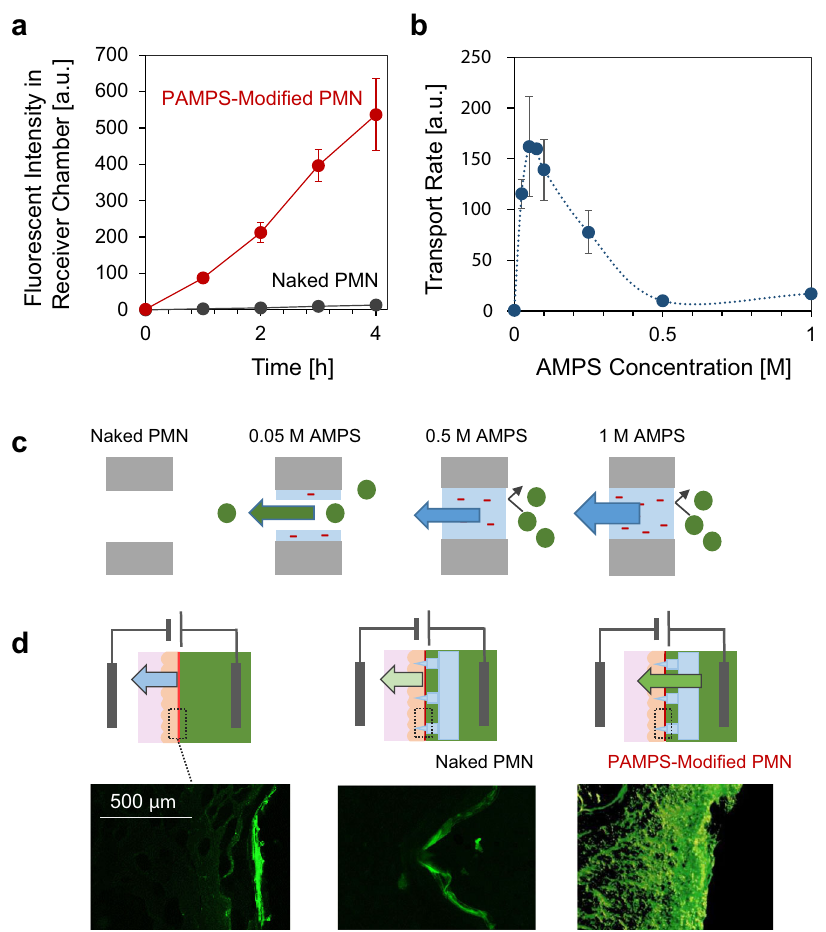
Fig. 4 Transport of large molecules. a The time-course of fl uorescent intensity of FITC-dextran transported to the receiver chamber through the naked PMN (black) and the PAMPS-modi fi ed PMN (red) at 3 mA/cm 2 ( N = 3 independent experiments; mean ± SD). b The transport rate of FITC-dextran at 3 mA/cm 2 as a function of AMPS concentration for modi fi cation of PAMPS ( N = 3 independent experiments; mean ± SD). c Schematic illustration of the sieving effect of the pore- fi lling PAMPS for larger molecules. d Cross-sectional fl uorescence images of pig skins after the transdermal application of 0.5 mA/cm 2 for 30 min without a PMN (left), with a naked PMN (center) and with a PAMPS-modi fi ed PMN (0.05 M AMPS) (right) ( N = 3 independent experiments for each